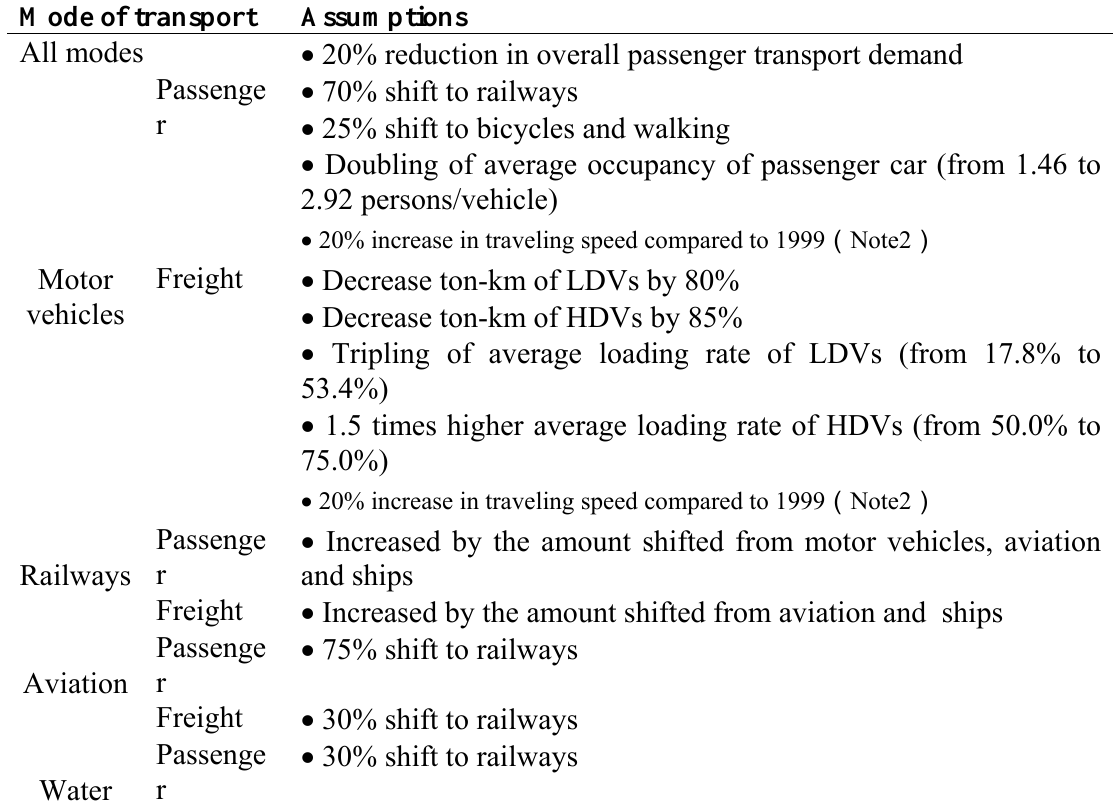
Table 9. Assumptions on transport activities in EST2 Scenario (Japan as a whole) Mode of